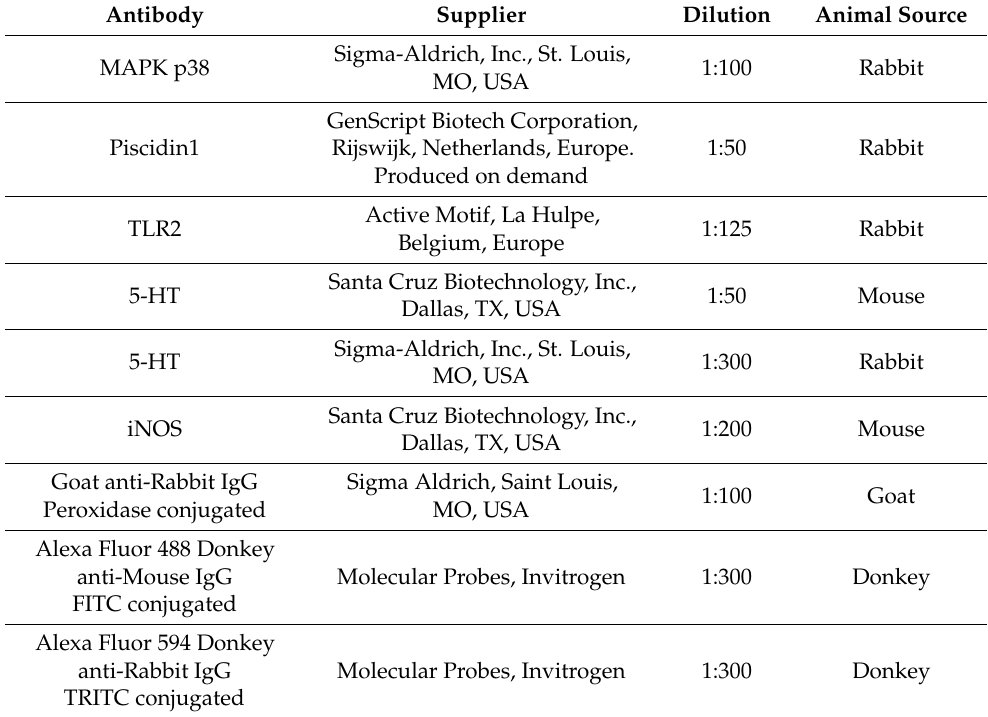
Table 1. Antibodies data.